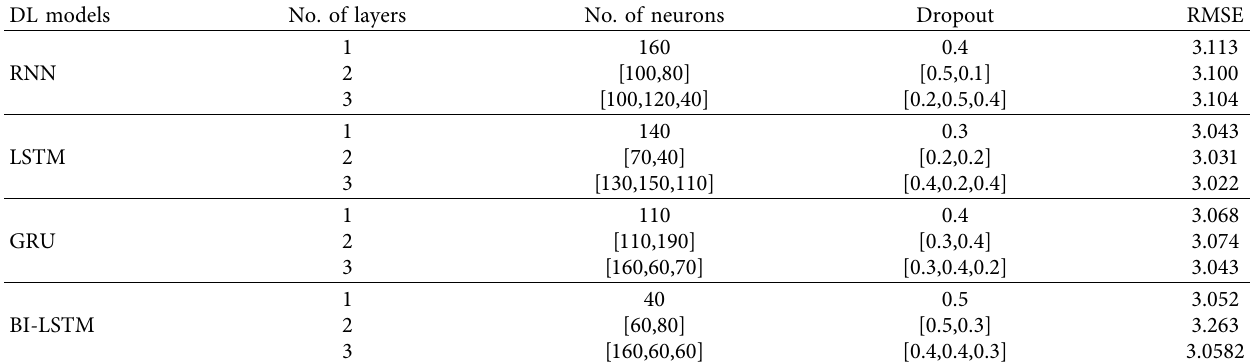
Table 4: The result of DL models for lag of 10 minutes and forecasting 15 minutes in advance. DL models